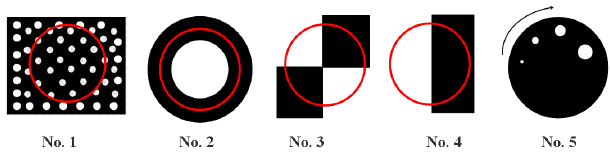
Figure 2. Five different attenuators used in the experiment. The red circle indicates the size of the beam. Check the text for detailed